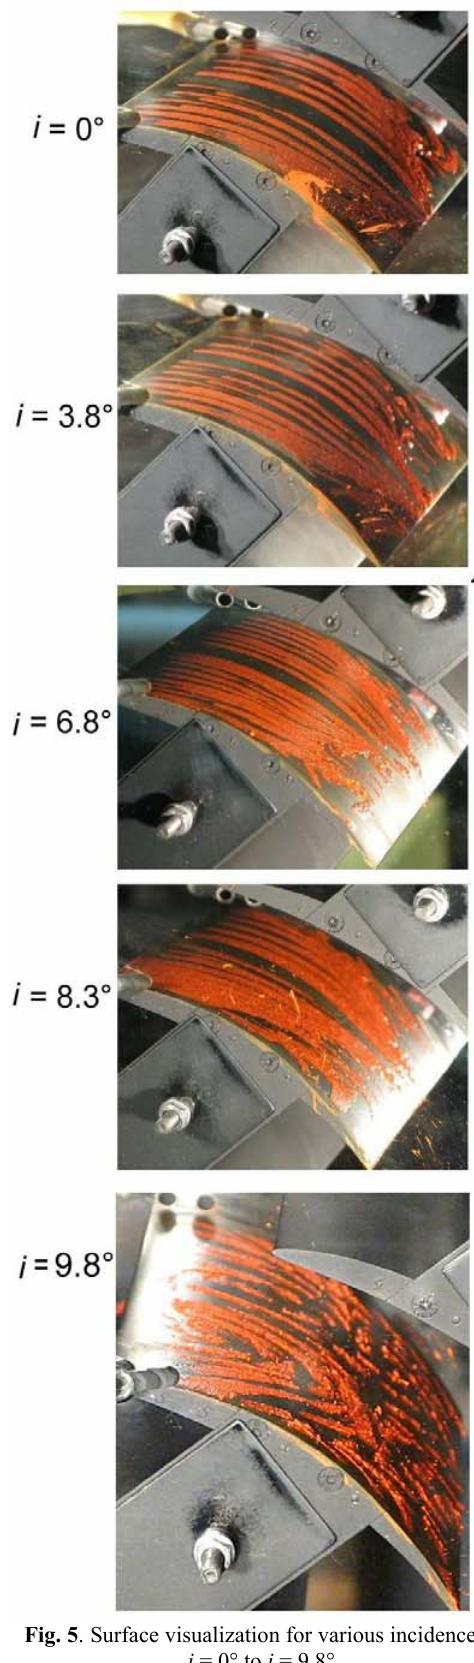
Fig. 5 . Surface visualization for various incidence angles i = 0° to i = 9.8°.